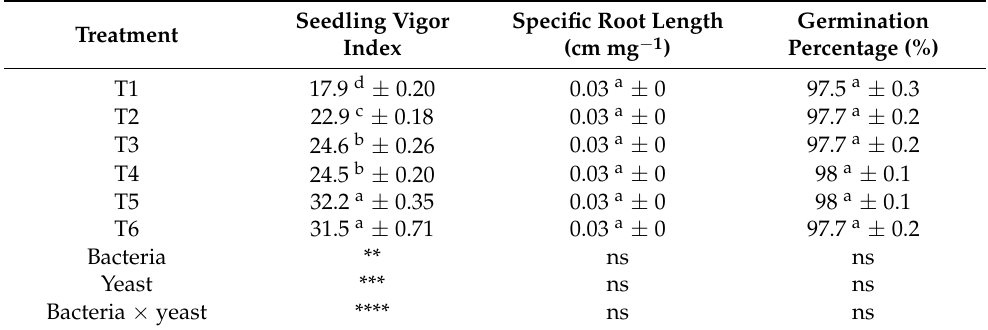
Table 1. Differences in the seedling vigor index, specific root length, and germination percentage of soybean at V c physiological